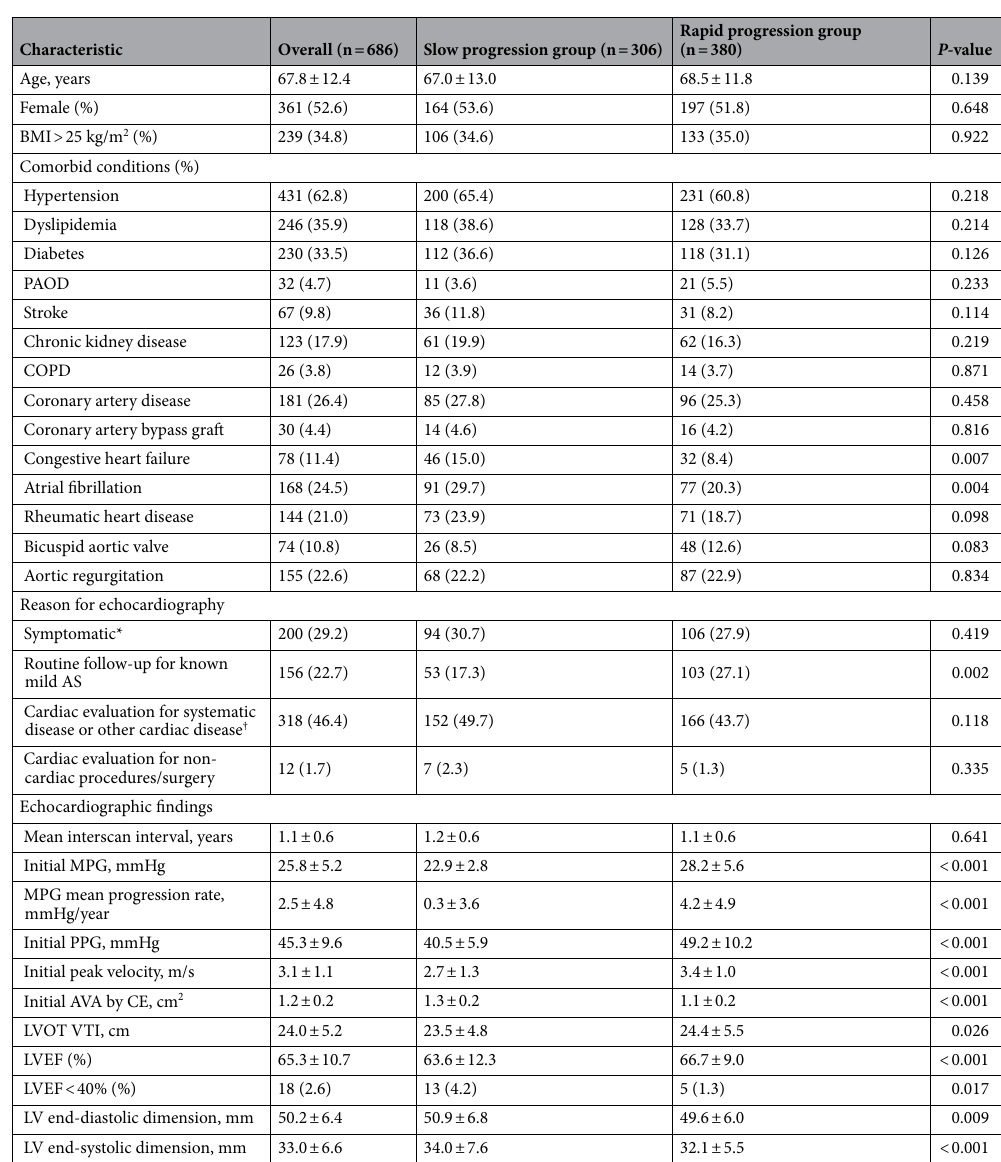
ejection fraction, LVOT left ventricular outflow tract, MPG mean pressure gradient, PAOD peripheral arterial occlusive disease, PPG peak pressure gradient, VTI time–velocity integral. *Symptomatic: Chest pain, dyspnea, syncope, dizziness, edema, general weakness. † Systematic disease or other cardiac disease: Other cardiac disease (arrythmia, coronary artery disease, hypertrophic cardiomyopathy, infective endocarditis), systematic disease (chronic kidney disease, intracranial hemorrhage,